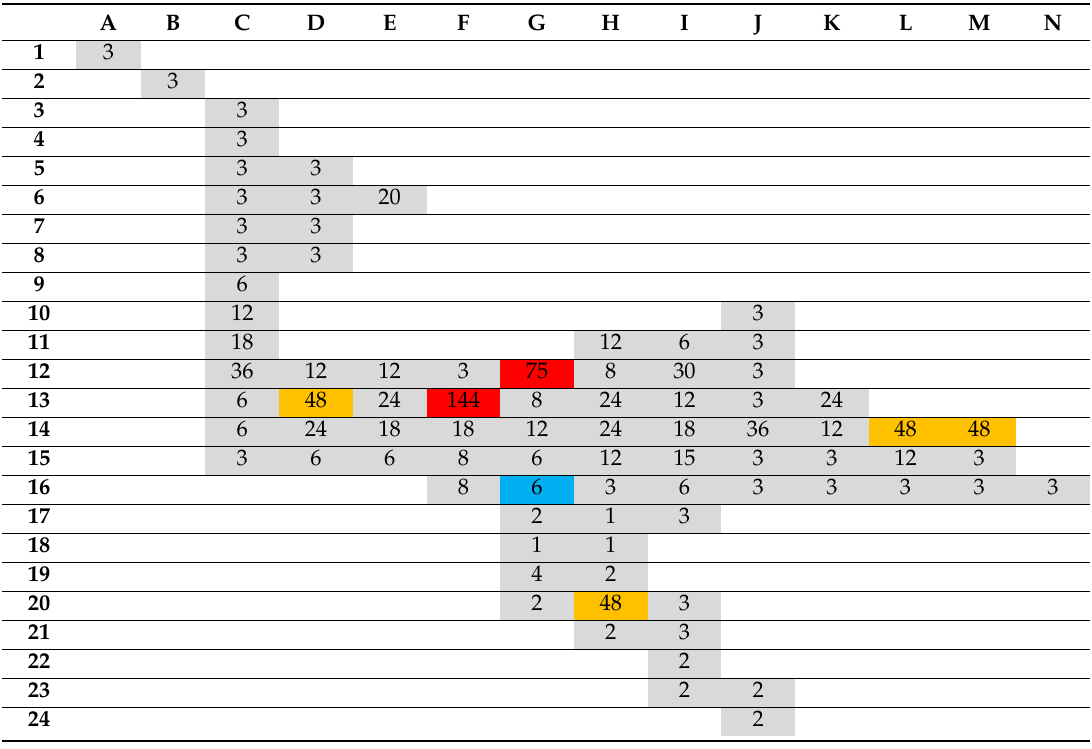
Table 7. Subareas with the highest ranking positions received by three analyzed methods. Sensor Placement,